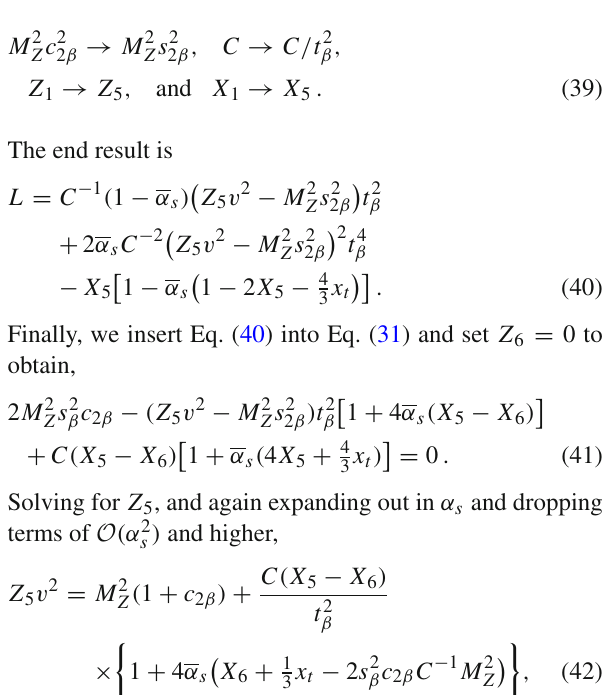
Fig. 2 Number of real solutions to the two-loop alignment condition, Eq. (38). We set Z 1 v 2 = 125 GeV. Left: All solutions with real tan β ; right: real, positive tan β solutions